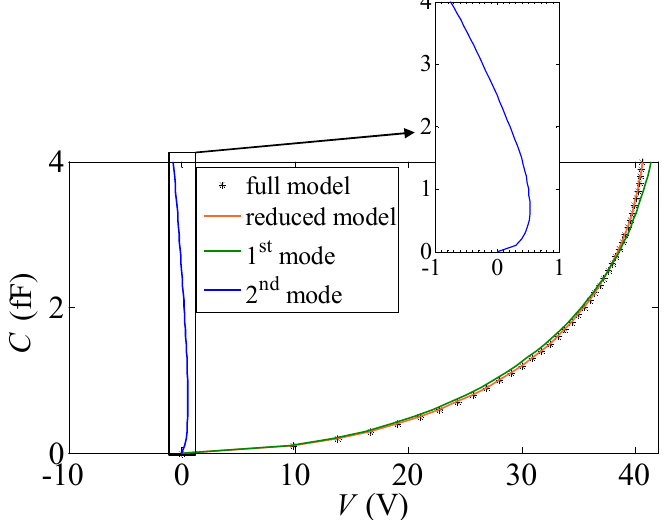
Figure 4. Comparison between full-order and reduced-order (featuring q = 2) responses for a device characterized by O = 0.15 µ m and E = 169 GPa, and representation of the two POMs retained to feed the kriging interpolation.